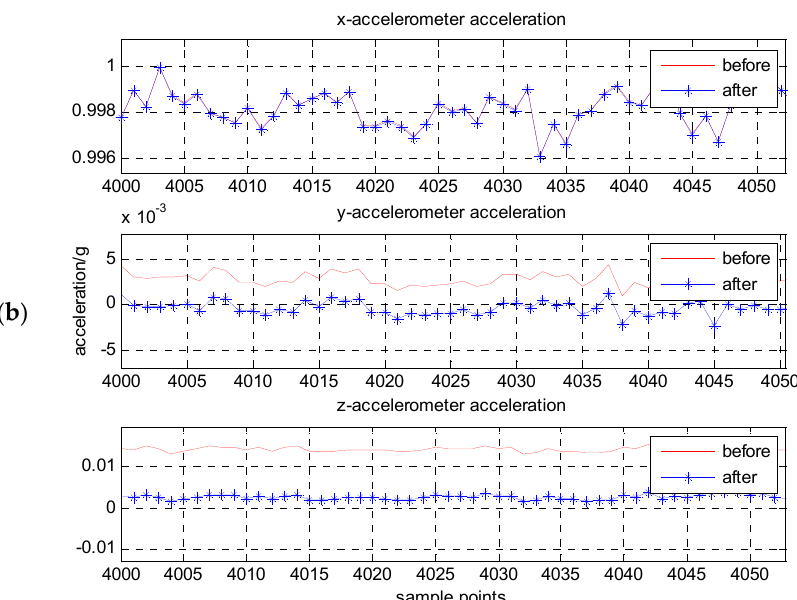
Figure 8. The contrast of three-axis acceleration before and after compensation when the x -axis, respectively, at ± 1 g position: ( a ) x -axis at − 1 g position; ( b ) x -axis at +1 g position. Table 4. Output of the tri-accelerometer unit when the accelerometer of the x -axis is ± 1 g. (unit: g). Theoretical Before After Sensor Output Compensation Compensation